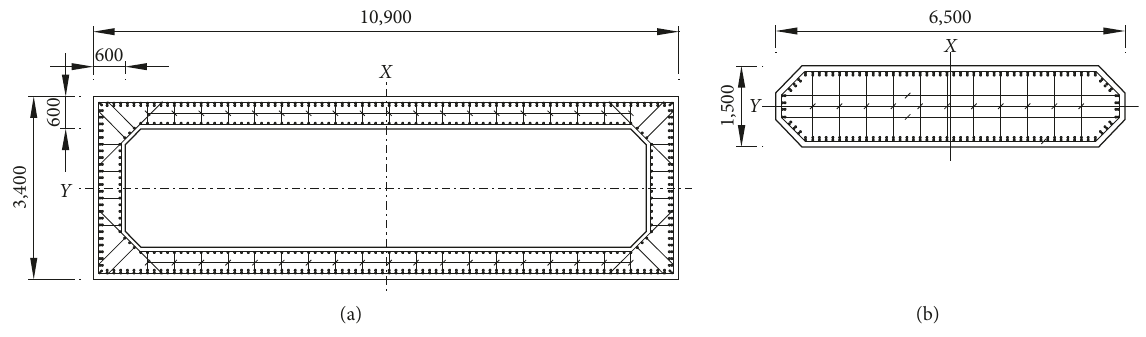
Figure 3: Cross section of the substructure (unit: mm). (a) Abutment. (b)